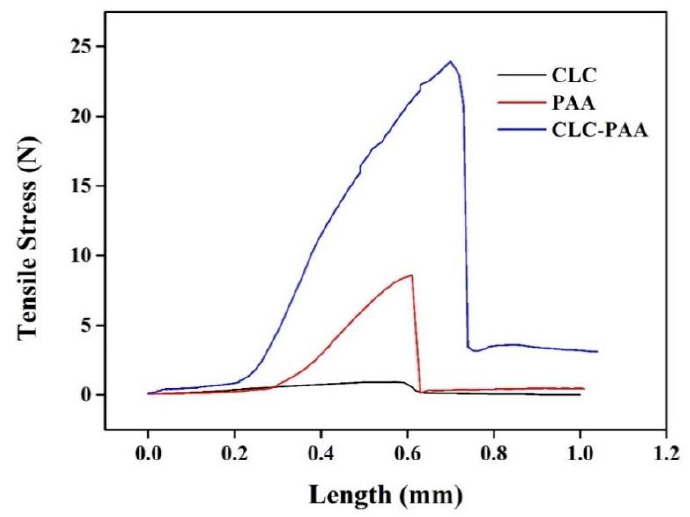
Figure 6. Tensile stress–strain curves of CLC, PAA and CLC-PAA films.